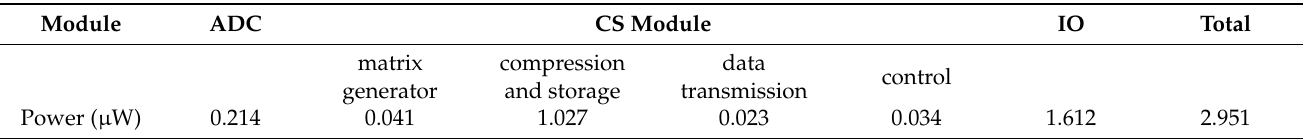
Table 3. The power consumption of the sampling and compression